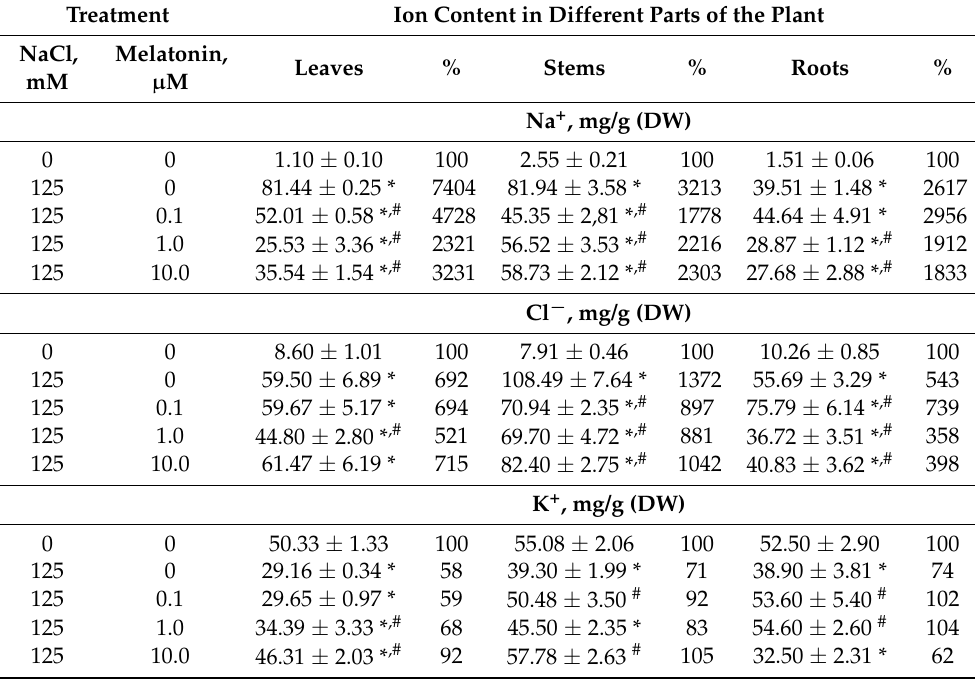
Table 2. Effect of melatonin and chloride salinity on the accumulation of inorganic ions in different parts of Solanum tuberosum